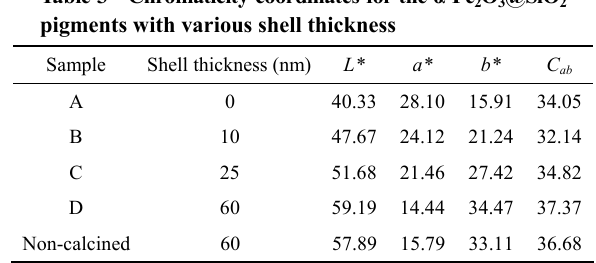
Table 3 Chromaticity coordinates for the α-Fe 2 O 3 @SiO